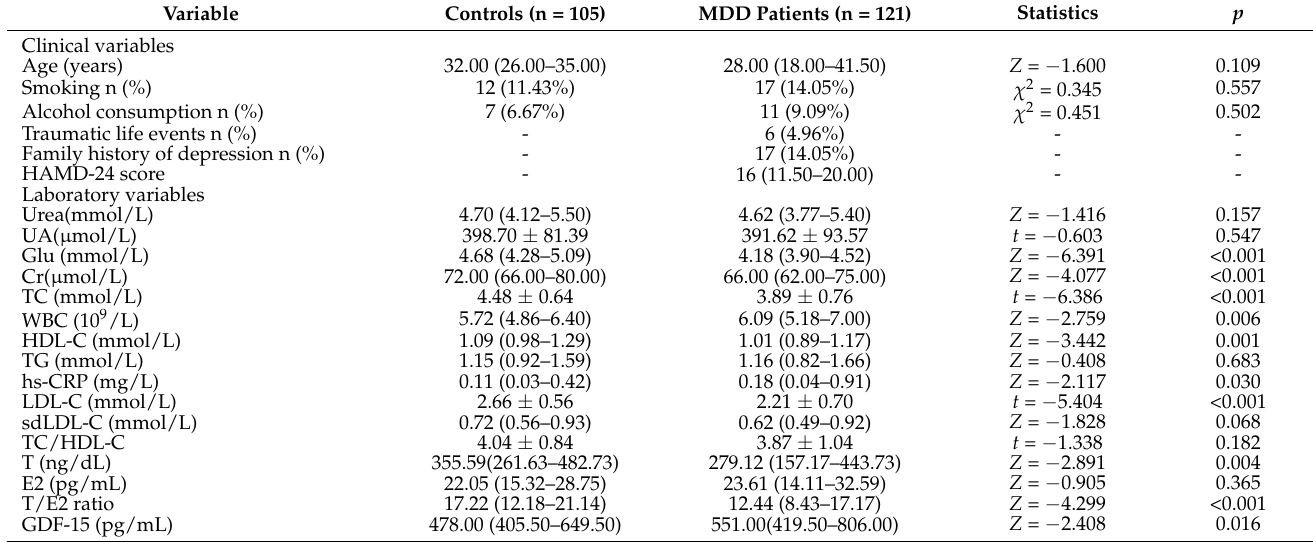
Table 1. Clinical characteristics of male MDD patients and